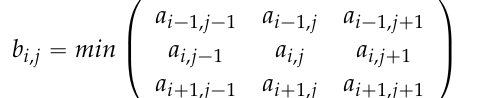
Figure 10. The figure on the left shows the Leave event, and the system enters the no-can state. The figure on the right shows a new Enter event with a fictitious Leave event, which closes the previous Enter event.